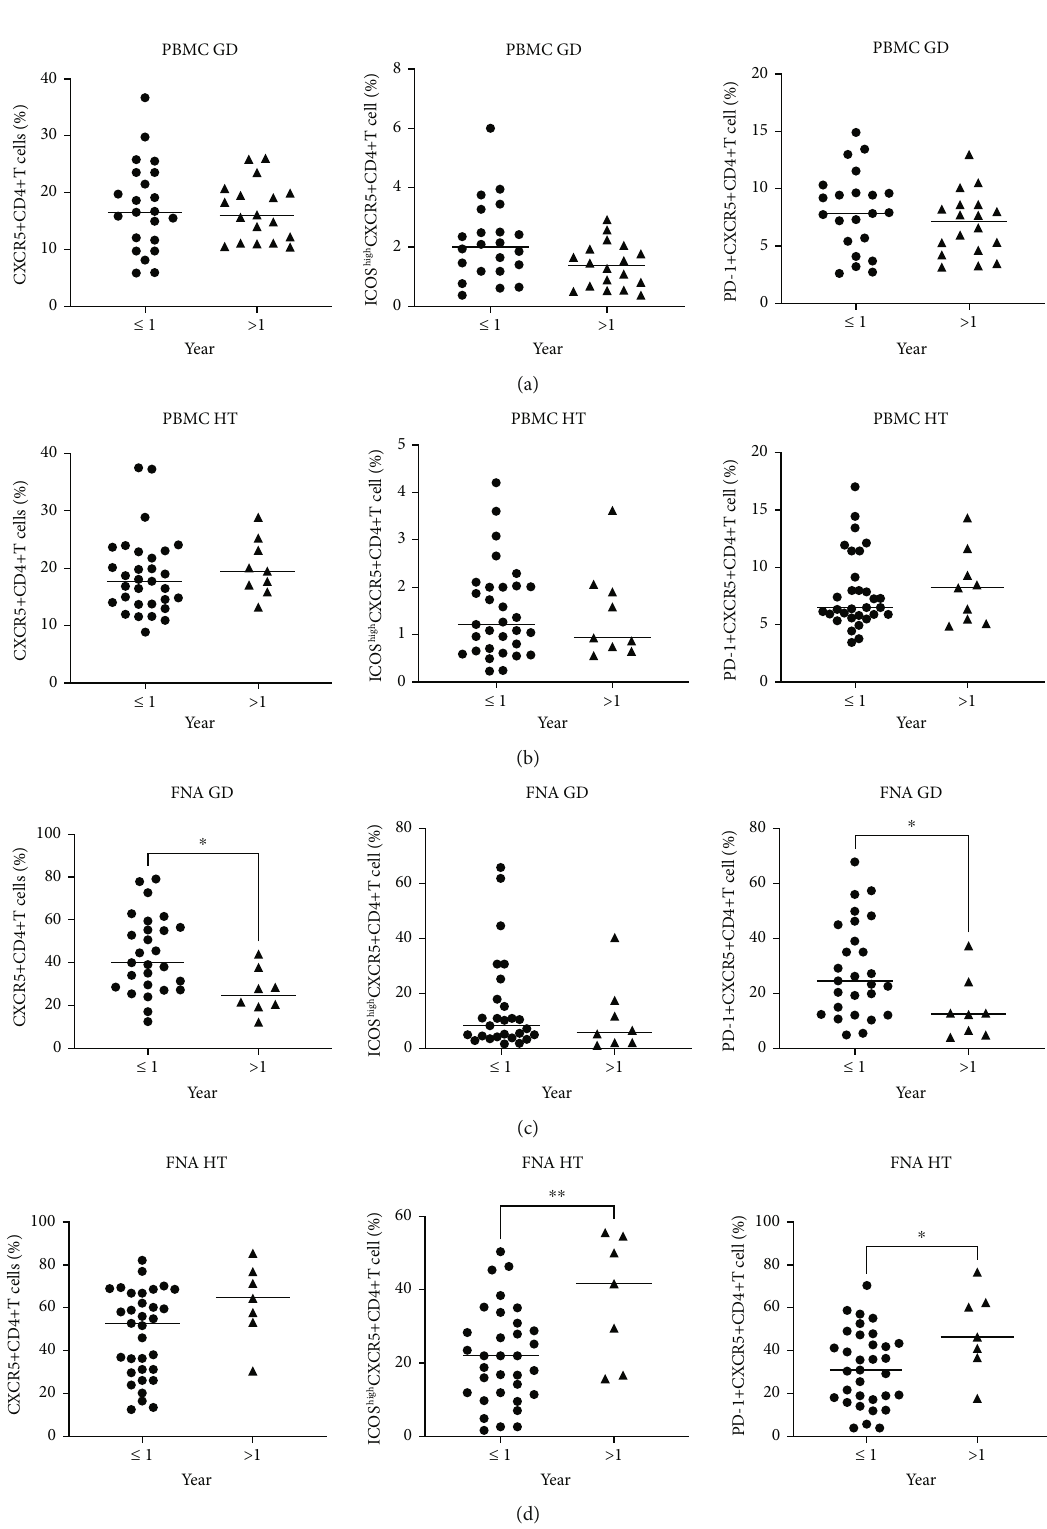
Figure 5: The frequency of Tfh cells in GD and HT patients with di ff erent disease durations. The frequencies of circulating CD4 + CXCR5 + , CD4 + CXCR5 + ICOS high , and CD4 + CXCR5 + PD-1 + Tfh cells in GD (a) and HT (b) patients diagnosed within 1 year and in those with a disease duration > 1 year. The frequencies of intrathyroidal CD4 + CXCR5 + , CD4 + CXCR5 + ICOS high , and CD4 + CXCR5 + PD-1 + Tfh cells in GD (c) and HT (d) patients diagnosed within 1 year and in those with a disease duration > 1